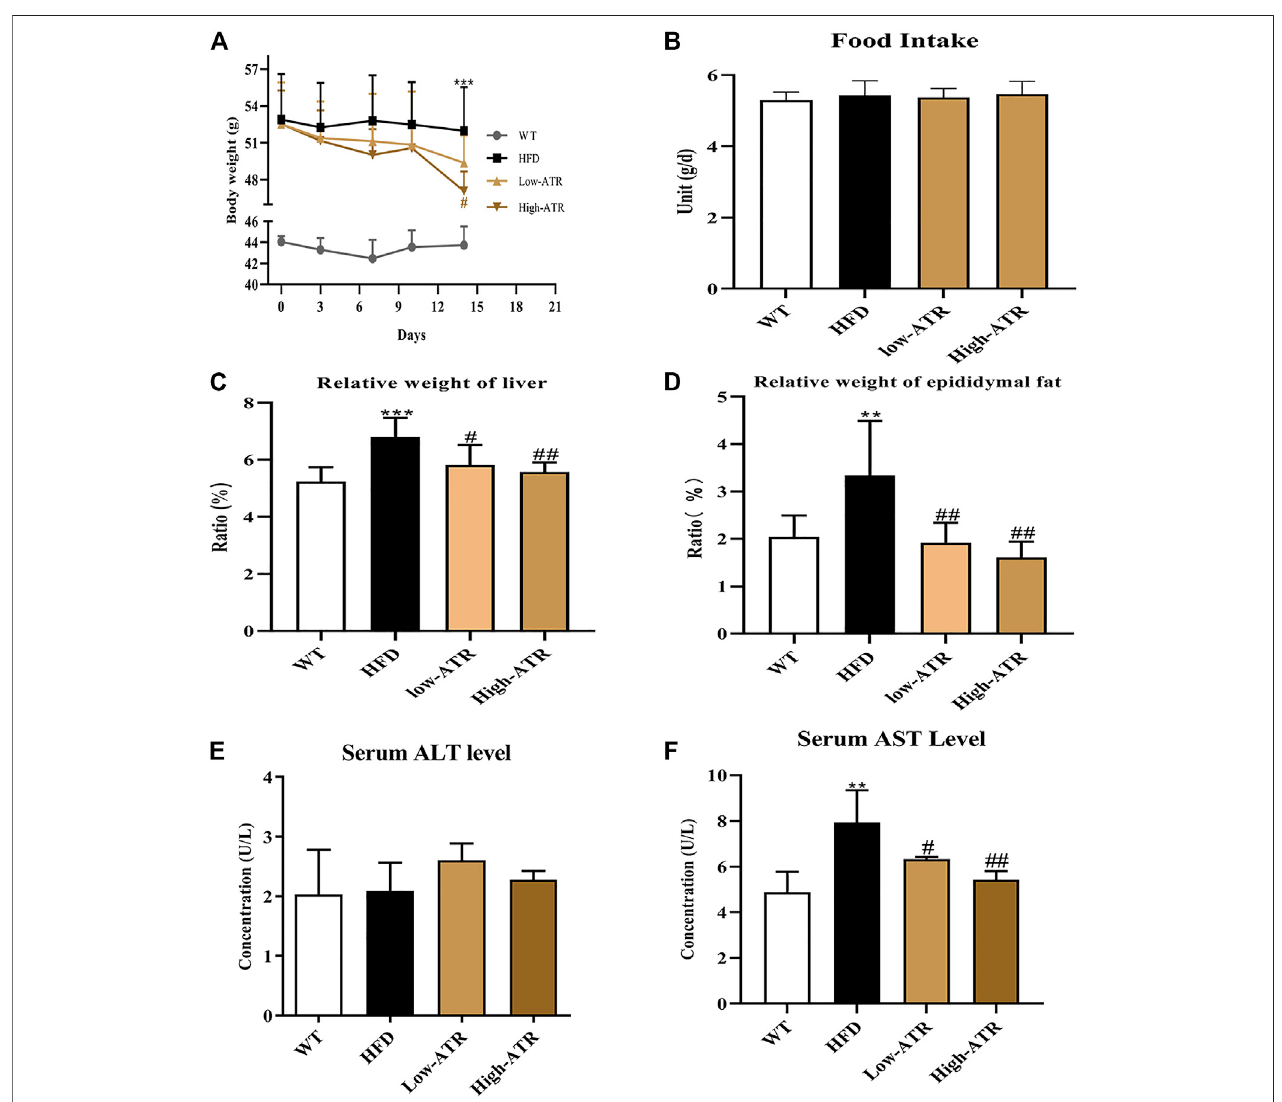
FIGURE 1 | Changes of body weight, relative weight of organs, and serum ALT and AST level in HFD mice. (A) 14-day body weight change. (B) Food intake. (C) Relative weight of liver (g/kg). (D) Relative weight of epididymal fat (g/kg). (E) Serum ALT level. (F) Serum AST level. Data are expressed as mean ± SD (n (cid:2) 8). * p < 0.05, ** p < 0.01, *** p < 0.001 (* represents HFD groups compared with the WT group). # p < 0.05, ## p < 0.01, ### p < 0.001 ( # represents ATR treatments compared with the HFD group). WT (cid:2) control group, and HFD (cid:2) high-fat diet group.